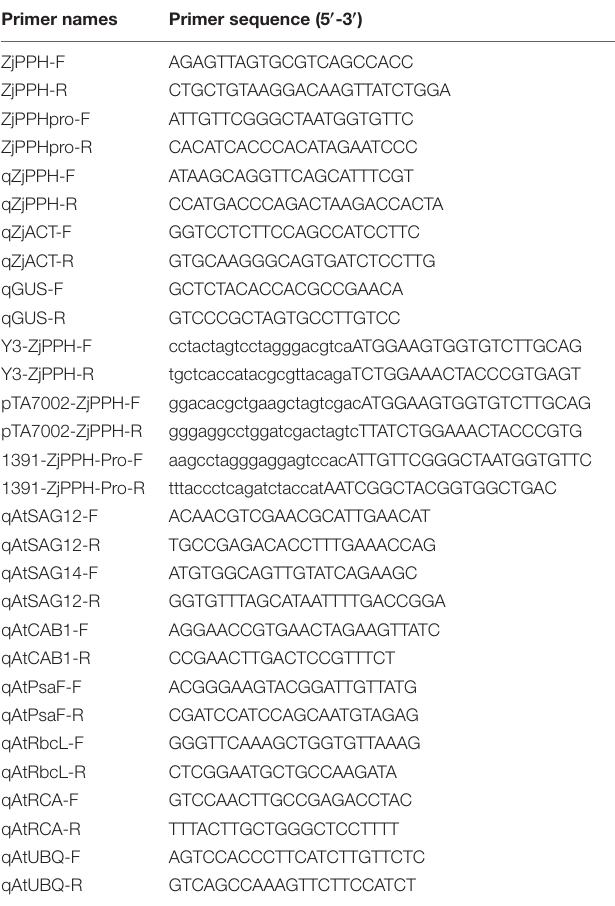
TABLE 1 | Primers used for gene cloning, expression analysis, and plasmids